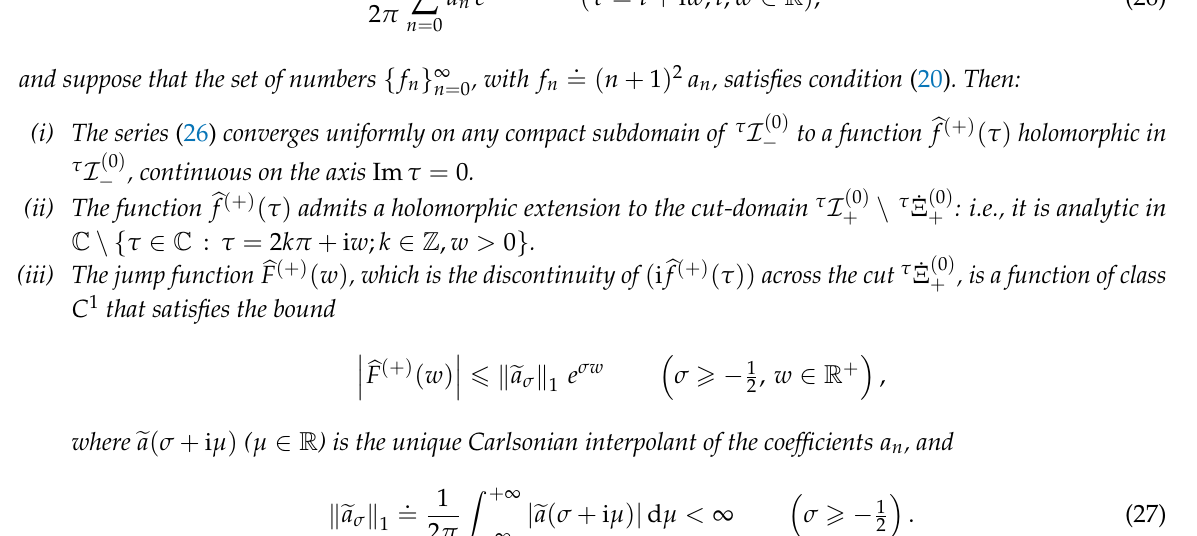
Figure 2. In the complex τ -plane, the grey regions represent: ( a ) the cut-domain τ I ( − ξ 0 ) \ τ Ξ ( − ξ 0 ) cut-domain τ I − − . The cuts (thick lines) are located at Re τ